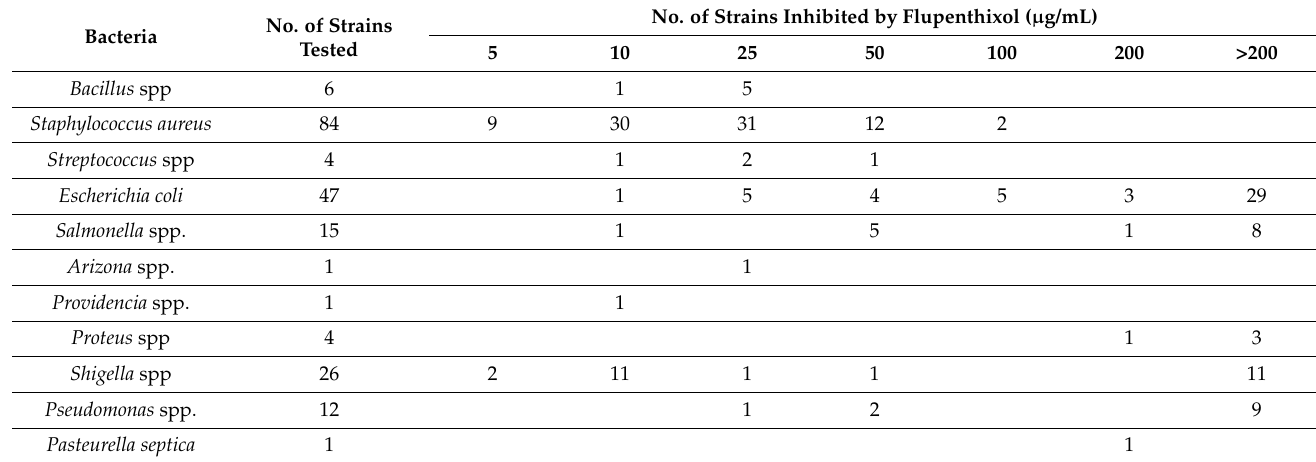
Table 4. In vitro antibacterial activity of